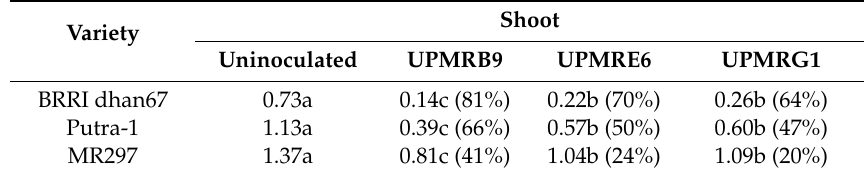
Table 2. E ff ect of bacterial inoculation on the ratio of Na / K (% decrease) in the above-ground parts (shoots) of three rice varieties under saline soil conditions. Shoot Variety Uninoculated UPMRB9 UPMRE6 UPMRG1